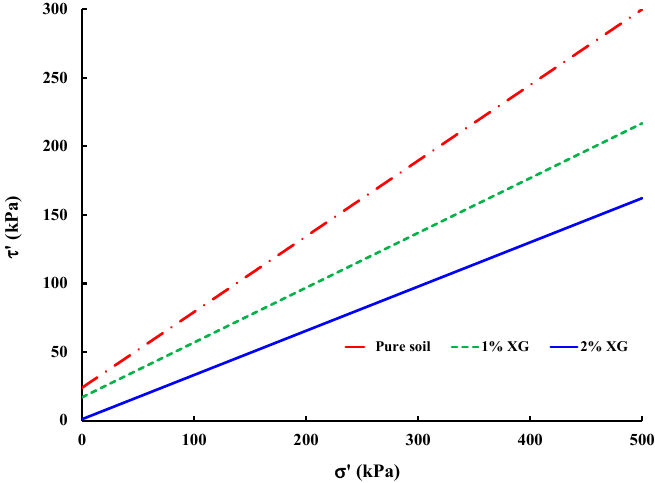
Figure 6. Effective shear stress vs. effective normal stress curves.